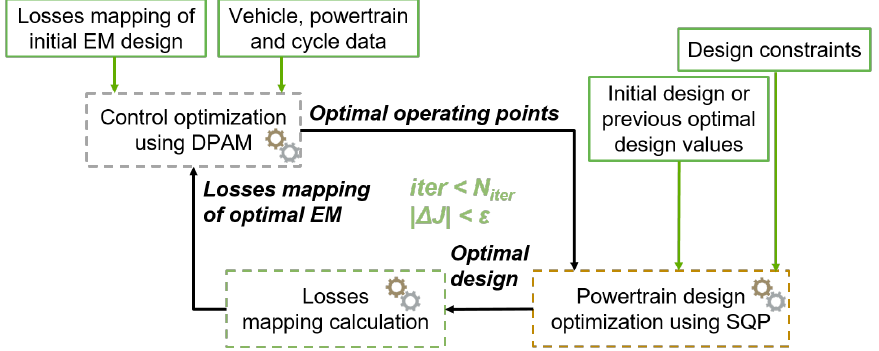
Figure 8. Application of the iterative framework for systemic design of the hybrid powertrain.